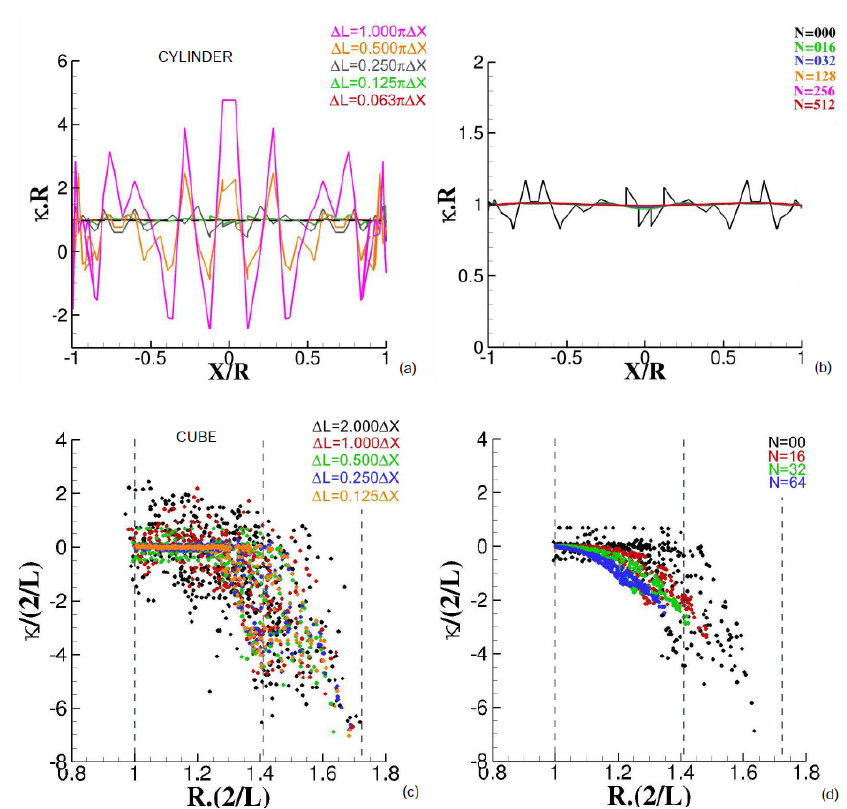
Figure A4. Interface curvature κ for the cylinder ( a , b ) and cube ( c , d ) cases: ( a ) and ( c ) impact of the ∆ L ∆ X resolution ratio with N = 0; ( b ) and ( d ) Impact of the N smoothing level with ( b ) ∆ L 1 ( d ) . For the cylinder case, X is the projection of the interface location on an arbitrary axis of the ∆ X = 2 R radius. For the cube case, R is the radial distance of the interface to the cube centre with a length L . The cube case. The orientations of the cubic body ( L is the side length) and the Cartesian grid influence the accuracy of the perceived geometric properties of the cube. A fully aligned cube with ∆ L = 1 a resolution ratio yields the theoretical solution for φ (the factor 1/2 comes from the use ∆ X 2 of a staggered grid). However, the numerical errors significantly increase when the parallelepipeds are not aligned with the grid. The most extreme case studied here corresponds to a cube whose faces present an angle of 45 degrees to those of the mesh (Figure A5a). The range of the resolutions ∆ L ] . Figure A4c plots the curvature (nondimensionalized by 2/ L ) depending on the ∈ [ 2 : 1 ratio is ∆ X 8 resolutions ratio (colour code) and the location of the interface points (defined by the distance to the cube centre, written R , and nondimensionalized by L /2). 2 R . L − 1 ∼ 1 corresponds to the centre of √ √ the cube surfaces and 2 R . L − 1 ∼ 2 (resp. 3) corresponds to the edges (resp. corners) of the cube. The local curvature at the cube interface is theoretically zero at all points except at singularities (edges and corners), where | κ |→ ∞ . Figure A4c demonstrates that the planar characteristic of the cube ∆ L (cid:38) 1 surfaces is clearly not respected for with N = 0 smoothing (the black, red, and green points). ∆ X 2 Some computed curvature values are as large as those of a sphere with a radius of L /2. The results ∆ L (cid:46) 1 become acceptable for (the blue and orange points in Figure A4c) even if the singularities have ∆ X √ 4 an influence for 2 R . L − 1 <